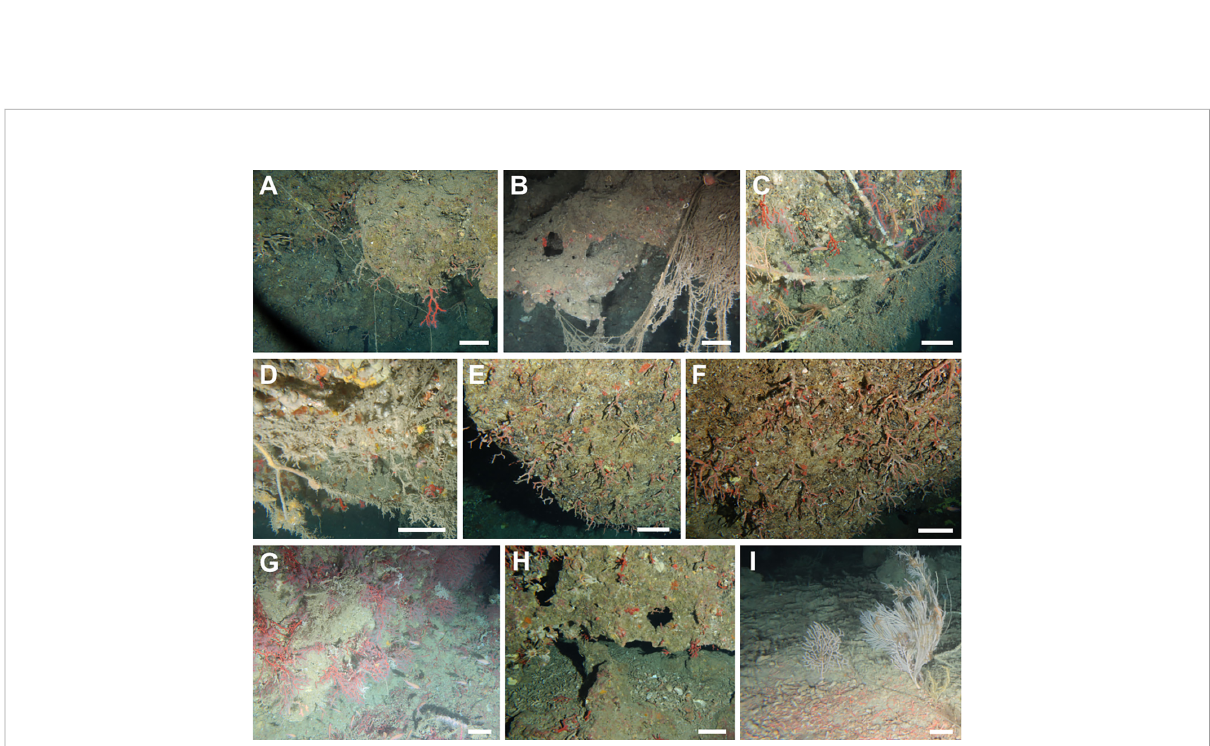
FIGURE 6 Fishing impact and mass mortalities. (A) Living and dead colonies entangled with a longline (Gulf of Salerno, 98 m); (B – D) nets impacting on Corallium rubrum (Milazzo Cape, 110 m; Ischia Island, 70 m; Bordighera Canyon, 70 m, respectively); (E, F) extensive mass mortality on the vertical rocky cliffs in Boi Cape (South Sardinia, 118 m); (G) large patch of coral fragments beneath fl ourishing living colonies (Graham Bank, Sicily Channel, 147 m); (H) coral fragments at the base of a rocky boulder hosting living and dead colonies (Porto Corallo, SE Sardinia, 87 m); (I) dense patch of C. rubrum fragments in the detritus (Graham Bank, Sicily Channel, 80 m). Scale bar: 10